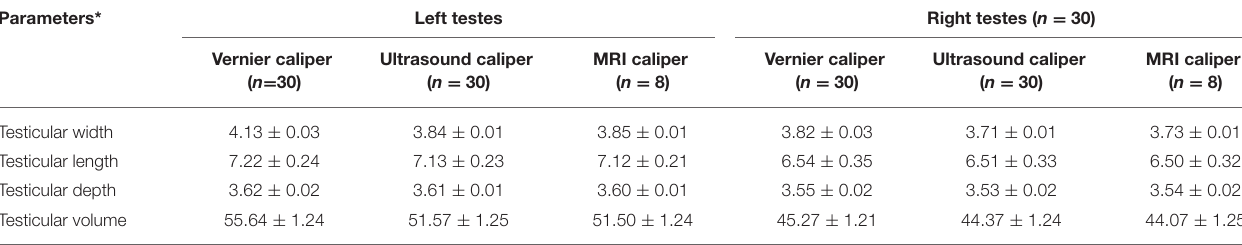
TABLE 1 | Camel testicular measurements by using the caliper and ultrasound scanning.